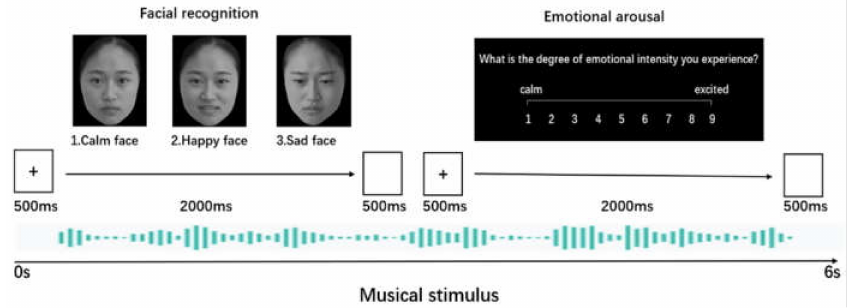
Figure 1. An example of the experimental